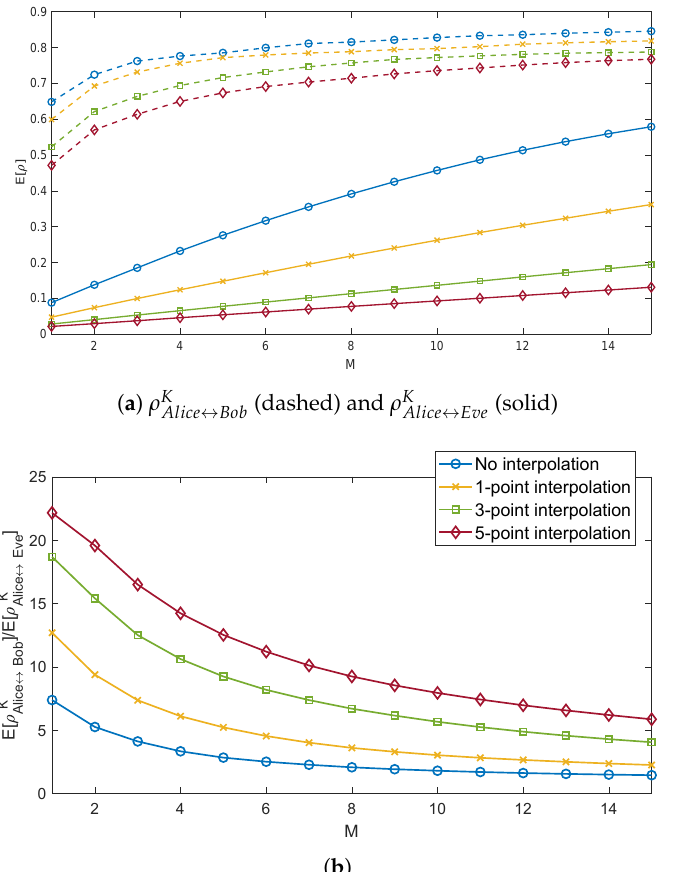
Figure 9. Correlation R of the sequence of peaks computed by Alice, Bob, and Eve ( a ) and their ratios ( b ), considering the first M peaks.